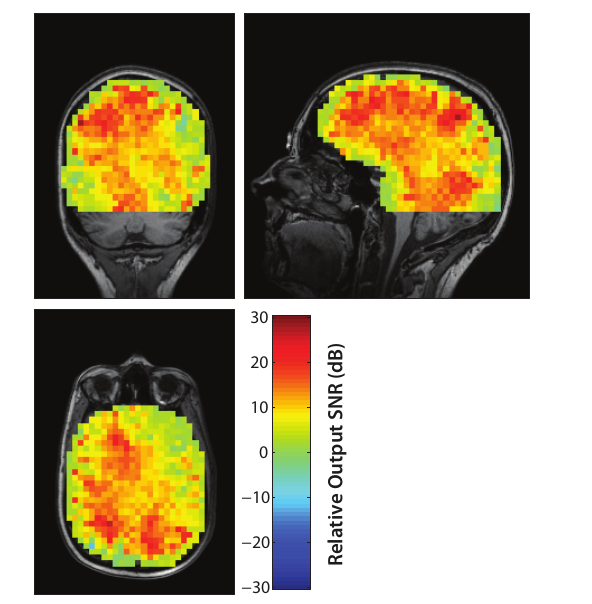
FIGURE 4 | The improvement in the output SNR of FlyTri-based reconstructions over Fastrak-based reconstructions are mapped here as a function of simulated source location, at an input SNR of − 5dB. The improvement covers nearly all brain regions, with no clear relationship to source depth.